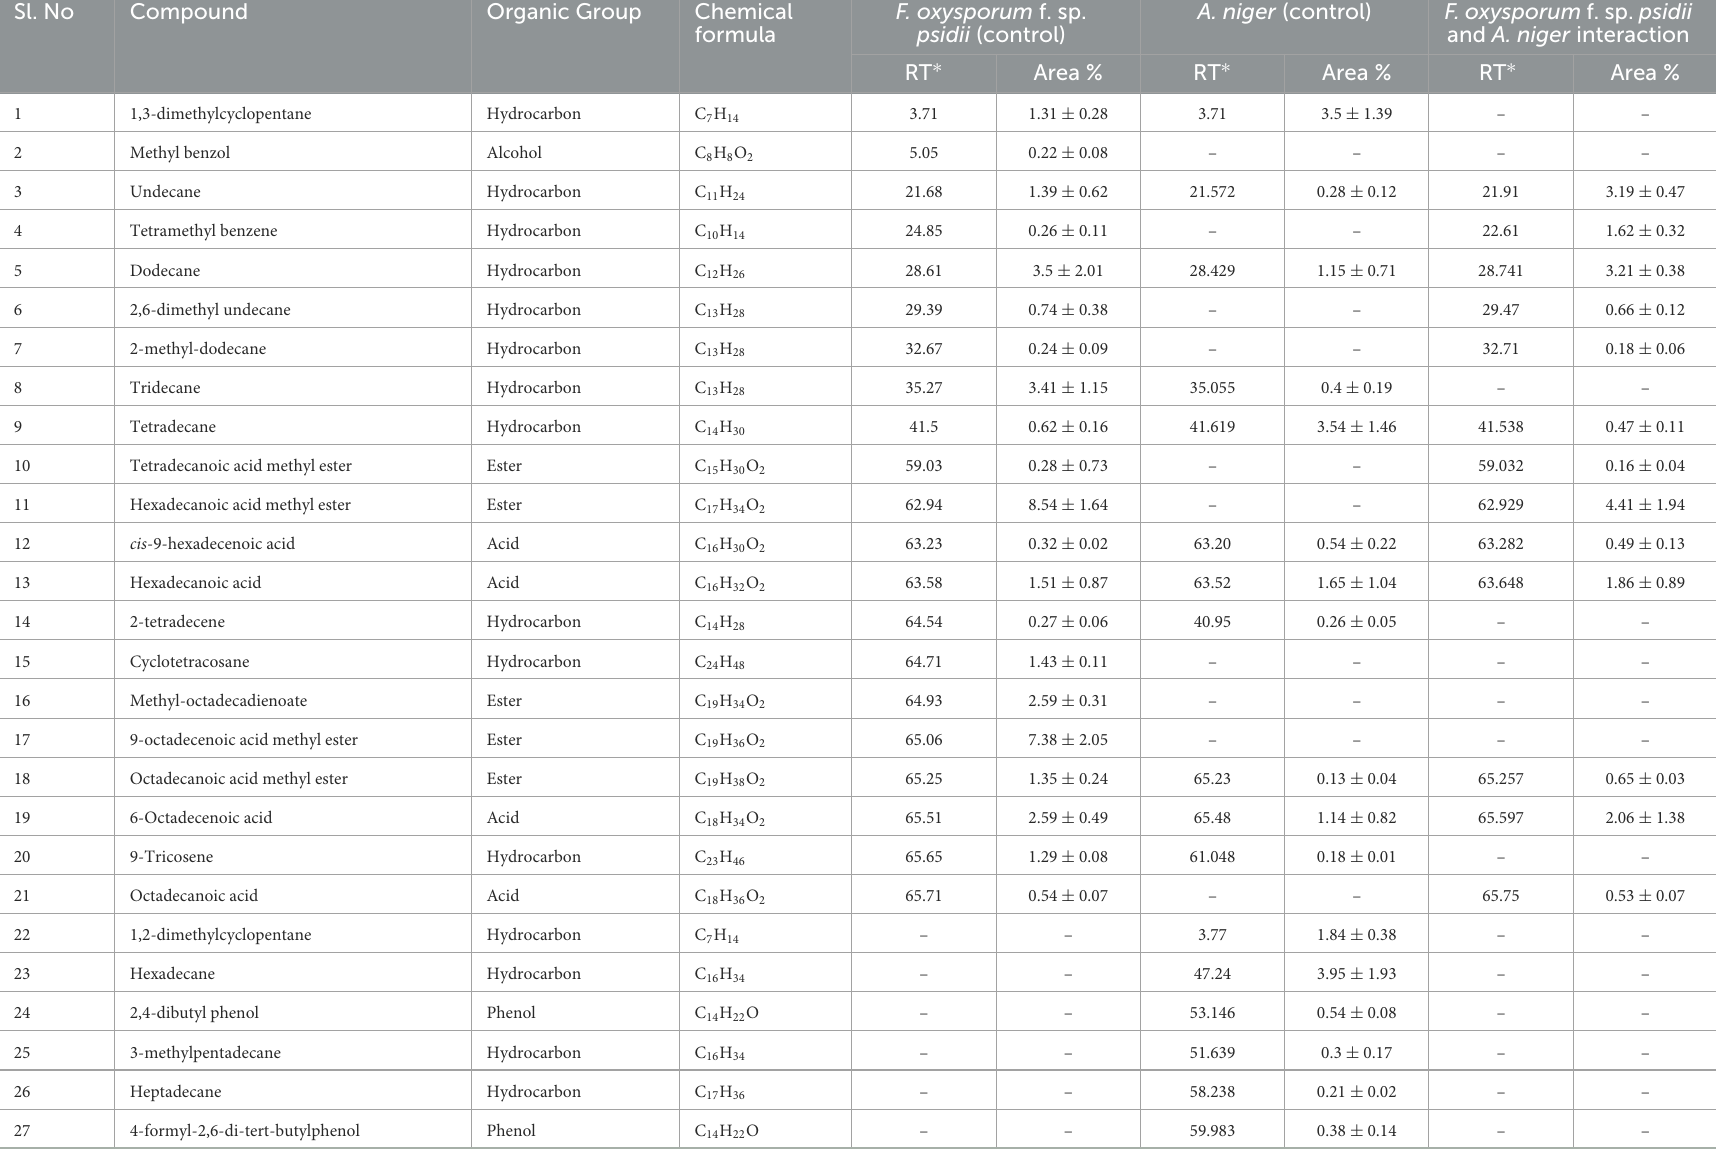
TABLE 4 List of volatile organic compounds (VOCs) in the hexane fraction during F. oxysporum f. sp. psidii and A. niger interaction, determined by GC–MS. Sl.